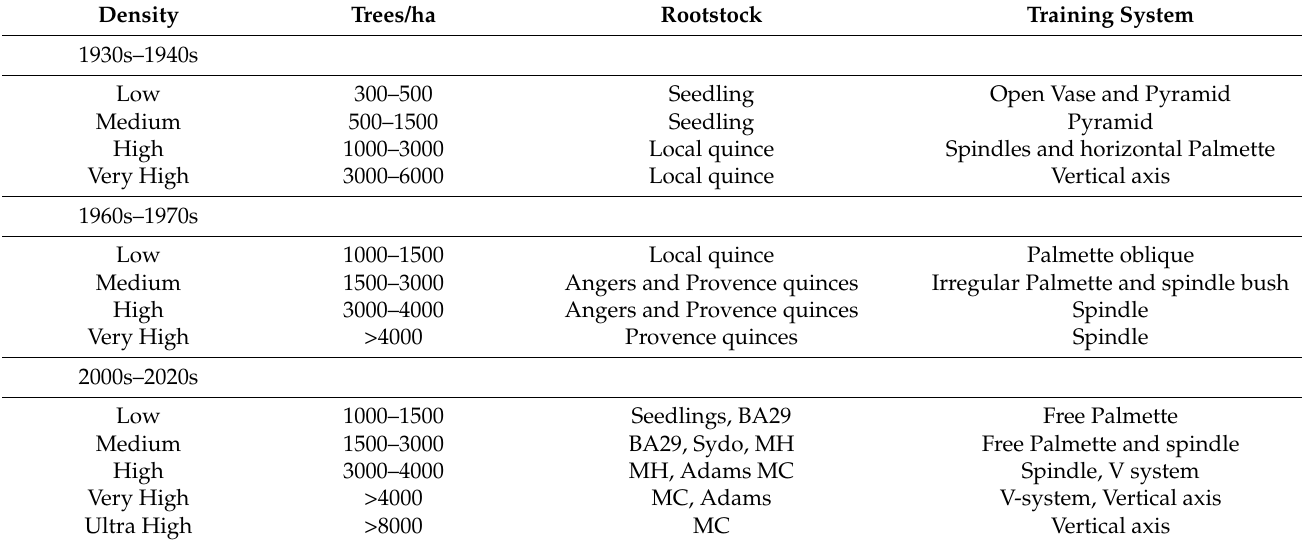
Table 1. Historical profile of pear orchard development in Italy’s main district (Po